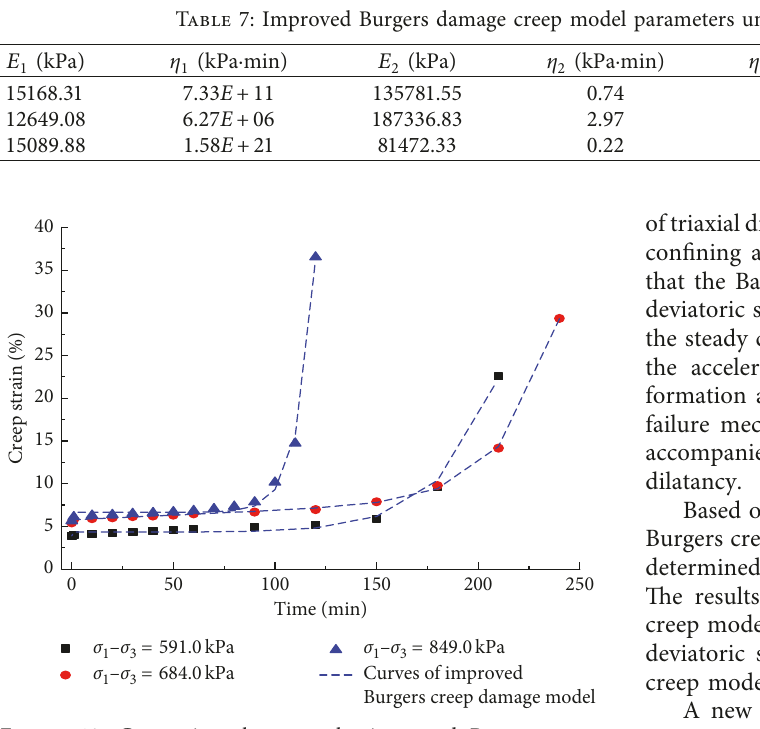
Figure 12: Comparison between the improved Burgers creep model’s prediction of creep curves and the tested